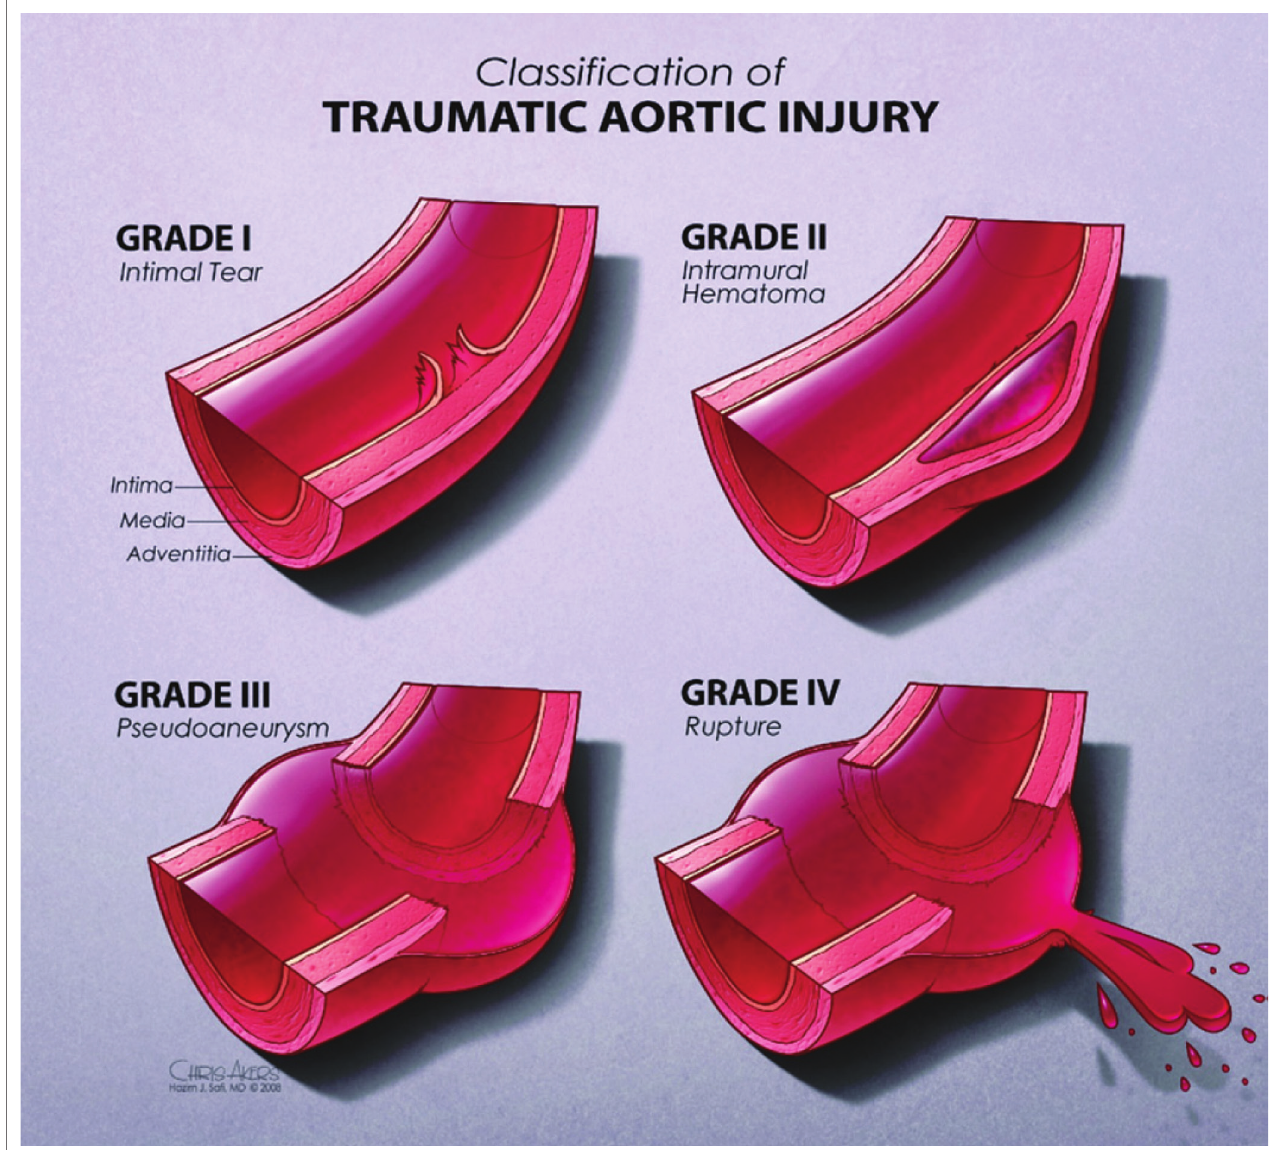
FIG URE 4: Diagram demonstrating aortic injury